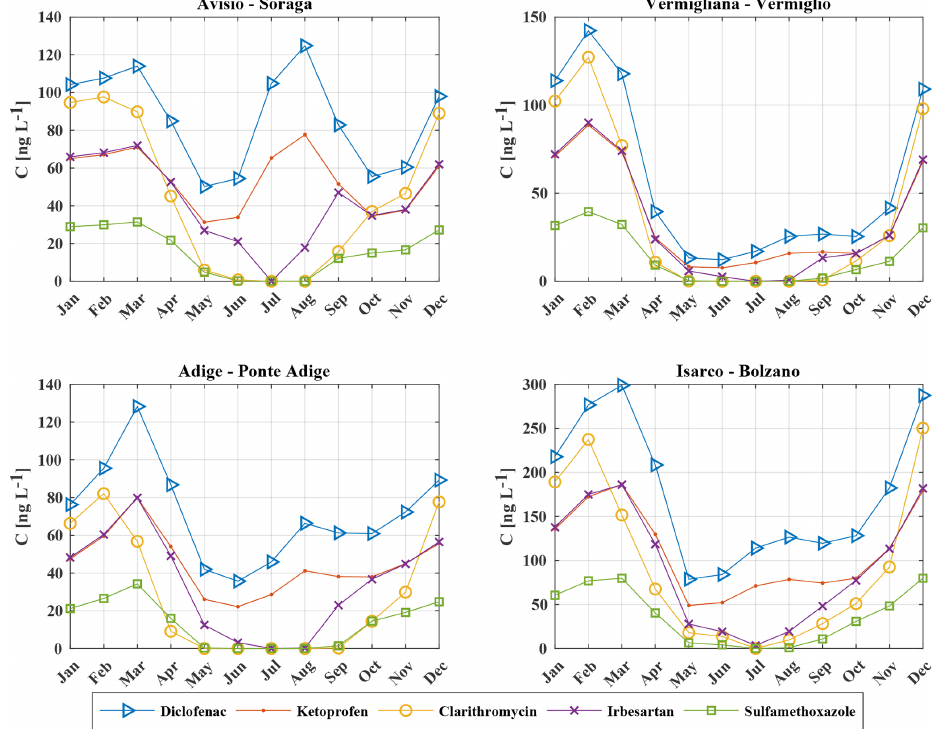
Figure 6. Monthly flux concentrations of five PPCPs (diclofenac, ketoprofen, clarithromycin, irbesartan, and sulfamethoxazole) at the control sections of Soraga on the Avisio River, Vermiglio on the Vermigliana creek, Ponte Adige on the Adige River, and Bolzano on the Isarco River. Concentrations are expressed in ngL − 1